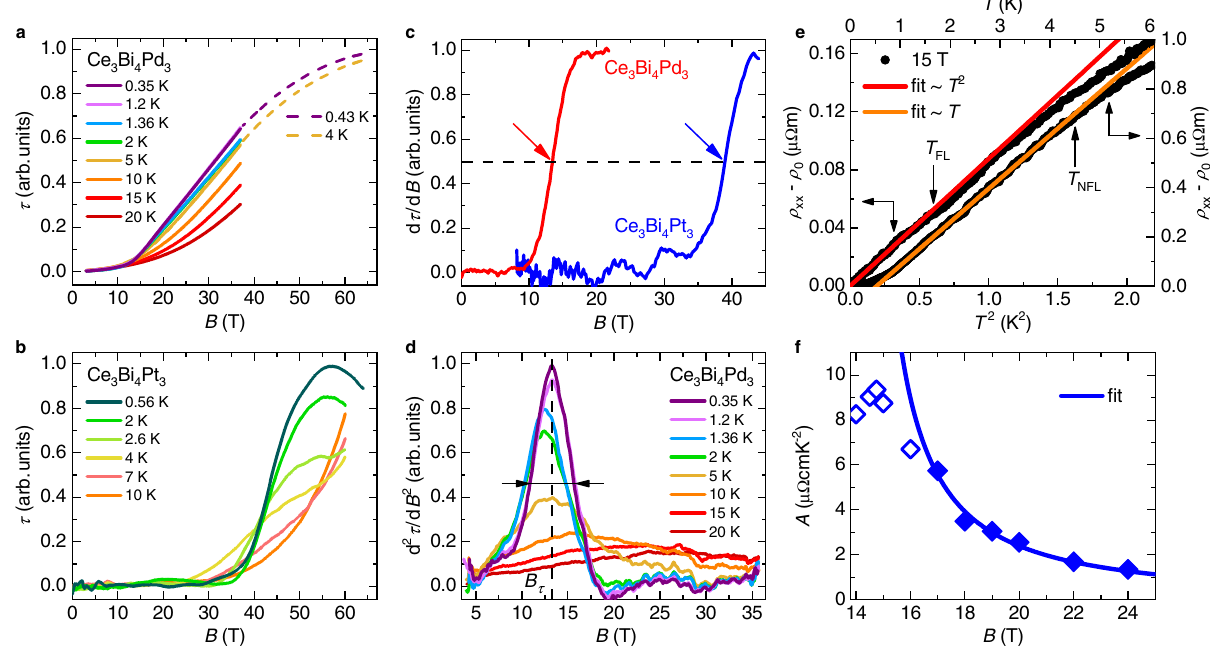
B (T) Fig. 3 | Field-tuned Kondo insulator to heavy fermion metal transition in and the horizontal arrows for the 0.35K isotherm. e Electrical resistivity of Ce 3 Bi 4 Pd 3 . a Magnetic torque isotherms of Ce 3 Bi 4 Pd 3 at various temperatures as Ce 3 Bi 4 Pd 3 at 15T, displaying linear-in- T 2 Fermi liquid behavior from the lowest functionofappliedmagnetic fi eldupto37Tand,forlowtemperatures,upto65T. temperature of 0.1K up to T FL (bottom and left axes, red line; above T FL , the data b Sameasin( a )fortheKondoinsulatorCe 3 Bi 4 Pt 3 . c Fieldderivativeofthemagnetic deviate by more than 5% from the Fermi liquid form ρ = ρ 0 + AT 2 ) and linear-in- T torque isotherms of Ce 3 Bi 4 Pd 3 and Ce 3 Bi 4 Pt 3 atthe lowest temperatures, revealing non-Fermiliquidbehaviorfromsomewhatabove T FL upto T NFL (topandrightaxes, similar characteristics, albeit at different fi elds (the fi elds where the step-like orange line; see Supplementary Note 11 for details). f Fermi liquid A coef fi cient vs increasesreachhalfheightareindicatedbyarrows). d Second fi eldderivativeofthe applied magnetic fi eld. The data above 16T are well described by A / ð B (cid:3) B c2 Þ (cid:3) p with B c2 =13.8T and p ≈ 1. Deviations at lower fi elds are attributed to proximity to torquesignalofCe 3 Bi 4 Pd 3 .Wede fi nethecharacteristic fi eld B τ ofthetorquesignal asthecenterofthewidthathalfmaximum,asindicated bythedashedverticalline a phenomenological crossover function 7 (see Supplementary Note 7 ~ R for details) one can extract not only the H values associated with the different phases, but also the crossover fi elds B * and sharpnesses, quanti fi ed by the full width at half maximum (FWHM). In Fig. 2a, b we